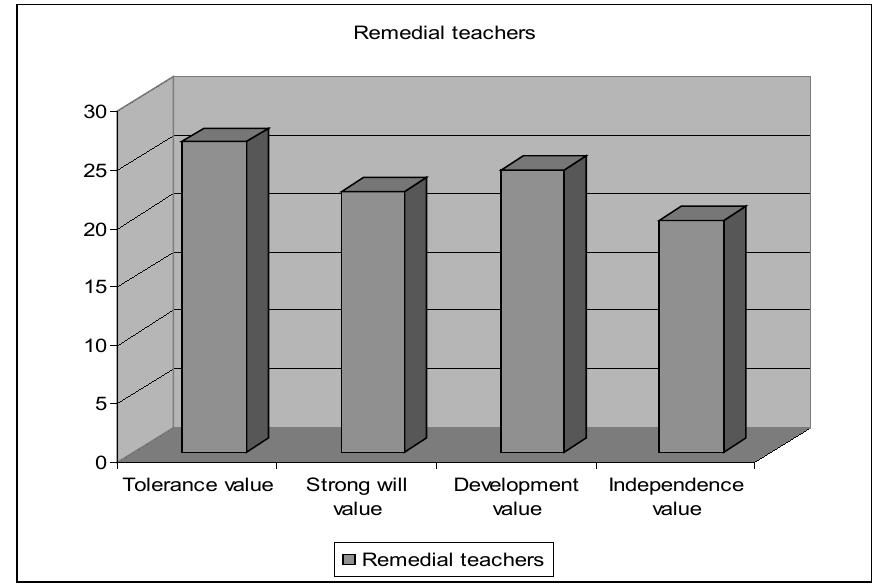
Fig. 1.2. The results of percentage analysis under M. Rokeach «Human values» methods in the group of remedial